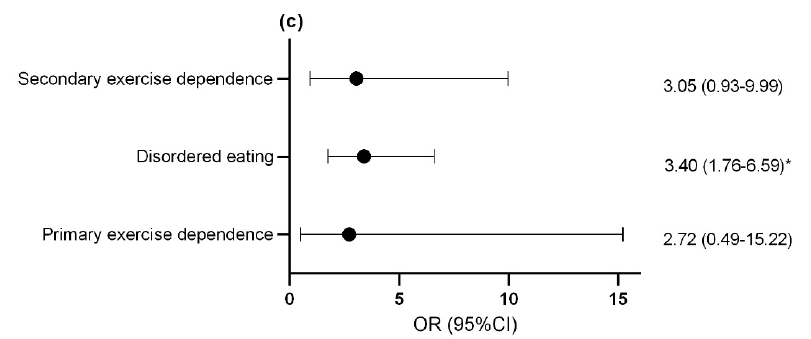
Figure 2. Odds ratio and confidence interval of ( a ) previous menstrual dysfunction ( b ) current menstrual dysfunction and ( c ) suppression of morning erections with disordered eating and exercise dependence status. * p < 0.05. OR, odds ratio; CI, confidence interval.